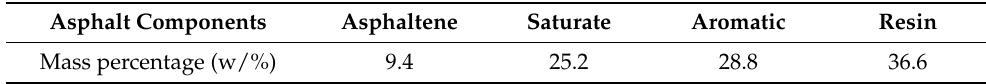
Table 2. Mass percentages of four components of matrix asphalt.